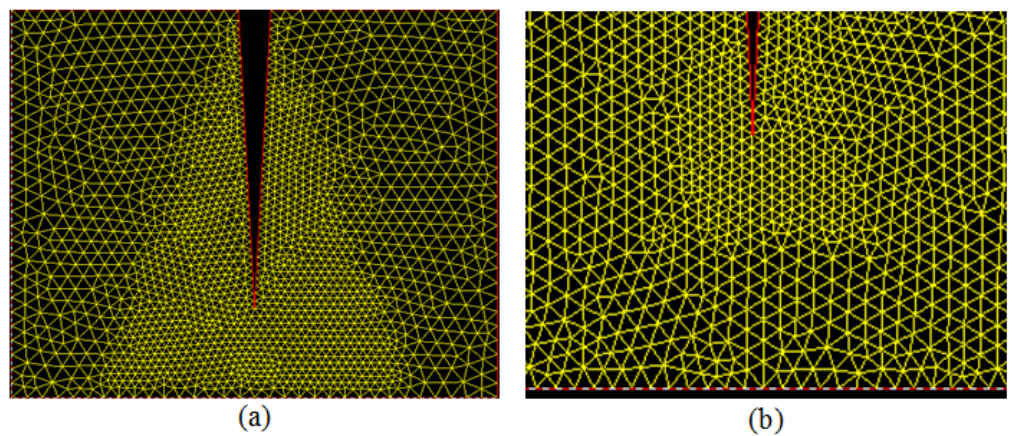
Fig.2: The grid for the pin - plane arrangement, a) a complete grid for the longitudinal cross section of the configuration, b) enlargement of the region around the tip of the pin